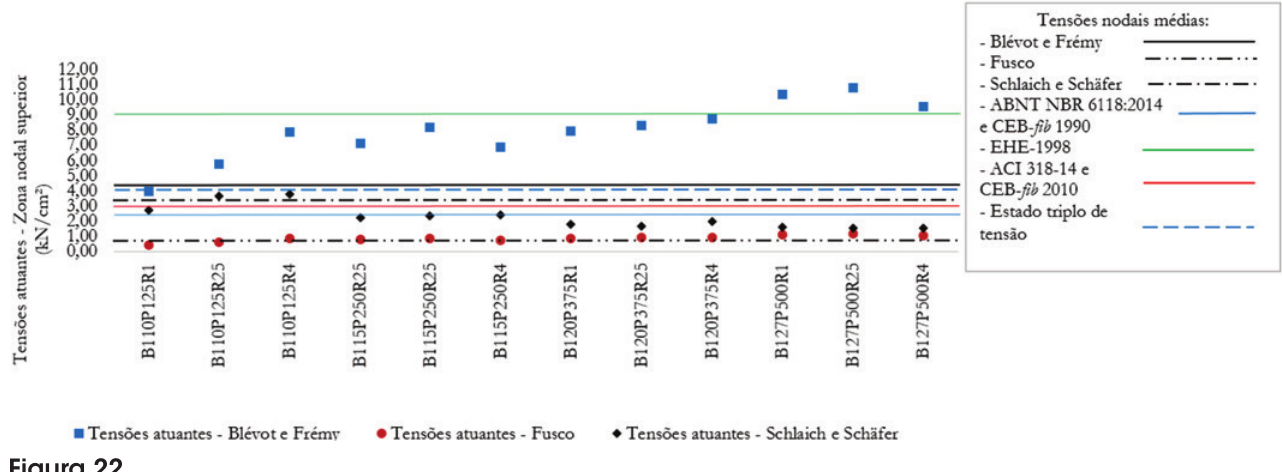
Modelos ensaiados por Munhoz [11] × σ